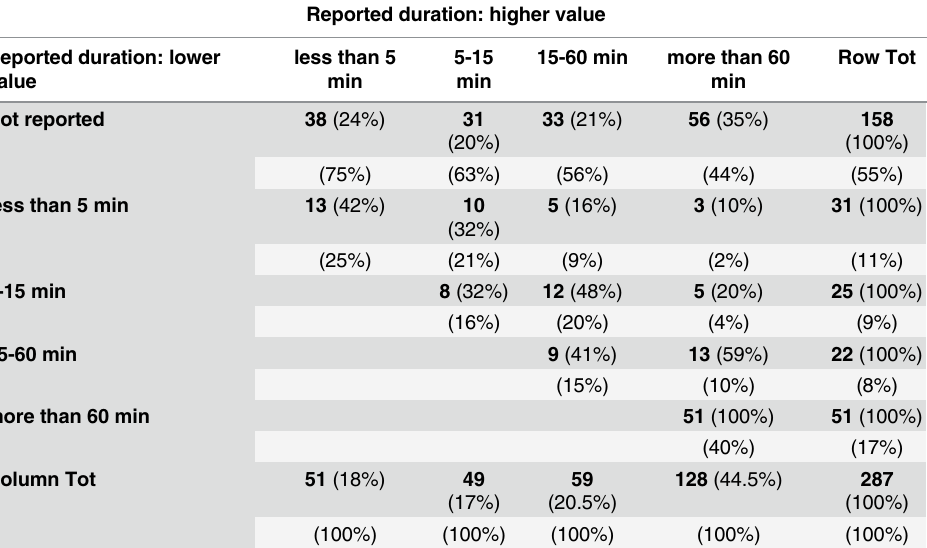
Table 1. Cross-tabulation of pairs of contact reports from the contact diaries. Each pair of participants with at least one contact reported gives a single observation. For instance, there were 12 pairs of students ( i , j ) such that i reported contacts with j with total duration between 6 and 15 min while j reported a duration between 15 min and 1 h. Each percentage within a cell represents the percentage with respect to the row (right of the cell entry) and column (below the cell entry)